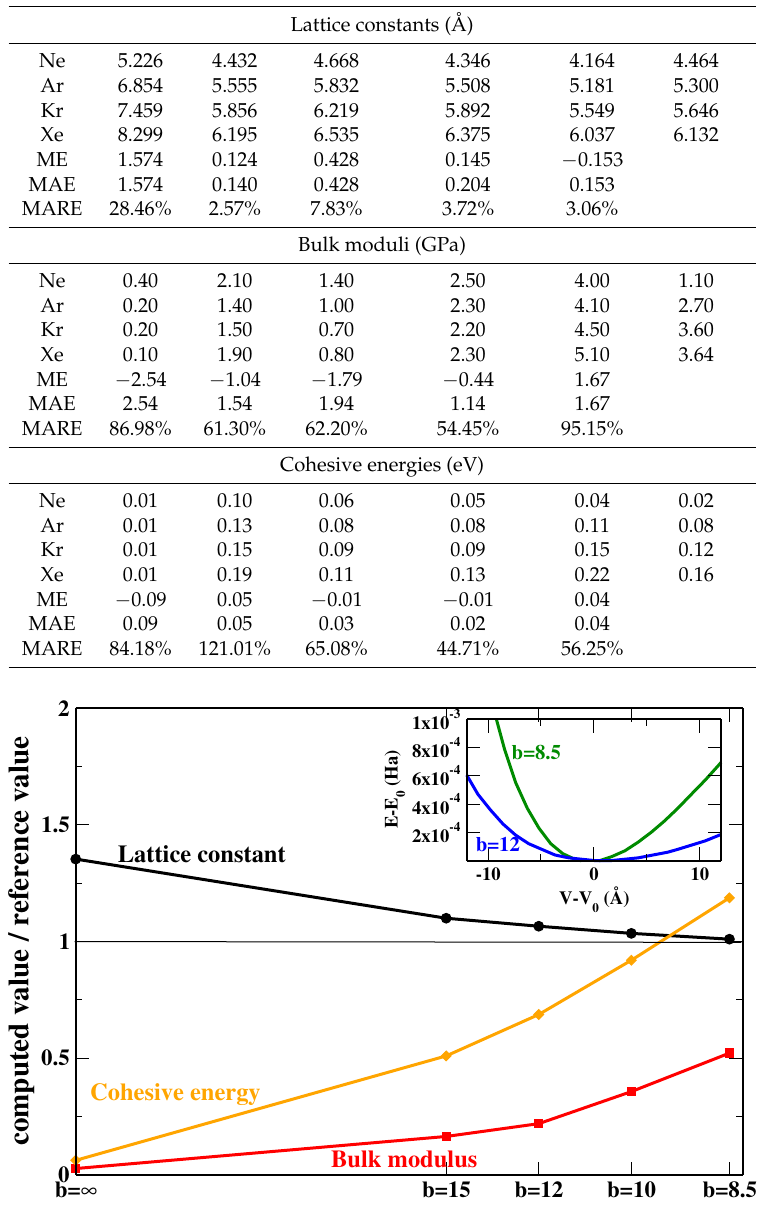
Figure 2. Relative variation of different properties of Xe as functions of the parameter b in the rVV10m correction. The inset reports the energy vs. volume curves for two values of b